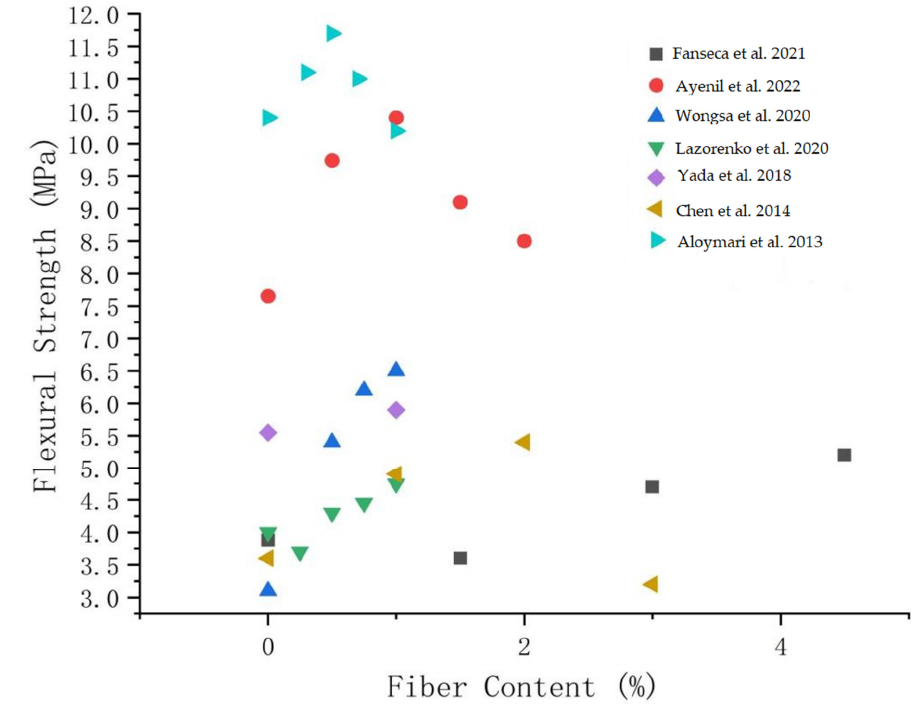
Figure 7. Relationship between fibers content and flexural strength